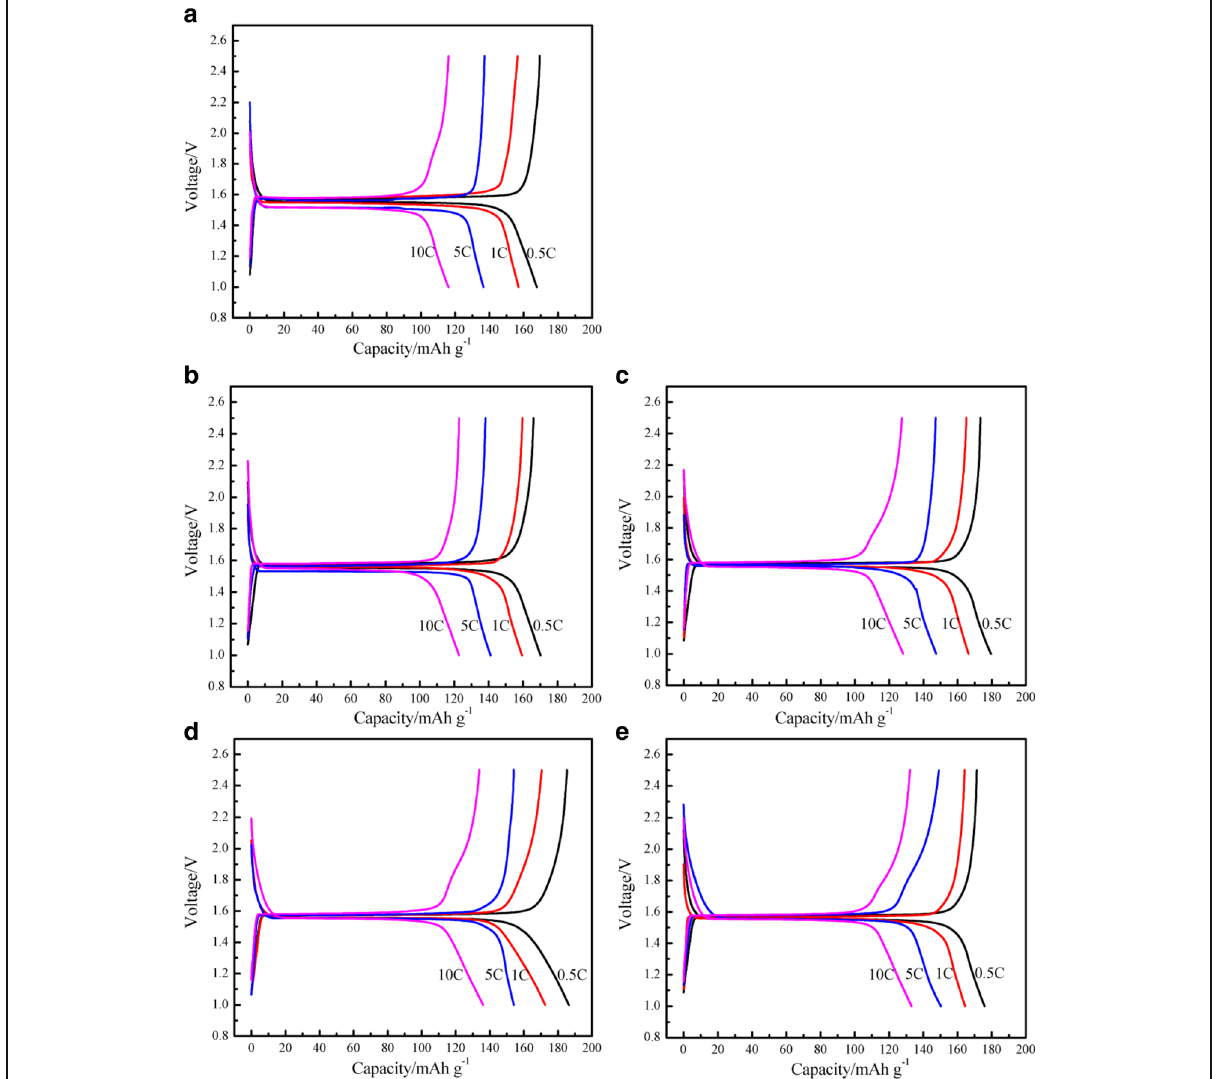
Fig. 4 The initial charge-discharge curves with various current densities of the Li 4 Ti 5 O 12 /Ag. ( a ) 0 wt.%, ( b ) 1 wt.%, ( c ) 3 wt.%, ( d ) 5 wt.%, ( e ) 7